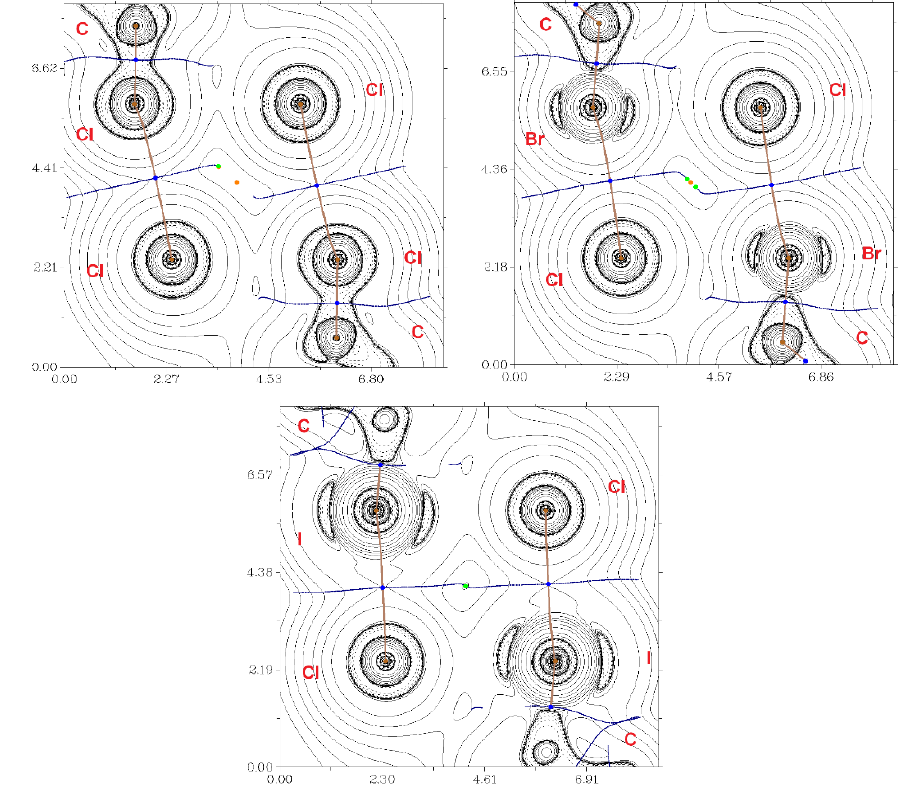
Figure 2. The contour lines demonstrate the Laplacian electron density distribution ∇ 2 ρ ( r ), bond paths, and selected zero-flux surfaces referring to the intermolecular non-covalent interactions of X ··· Cl (X = Cl, Br, I) in 1 (top, left), 2 (top, right) and 3 (bottom). The critical bonding points (3, − 1) are shown in blue, the nuclear critical points (3, − 3) – in pale brown, ring critical points (3, + 1) – in orange, and length units – Å.